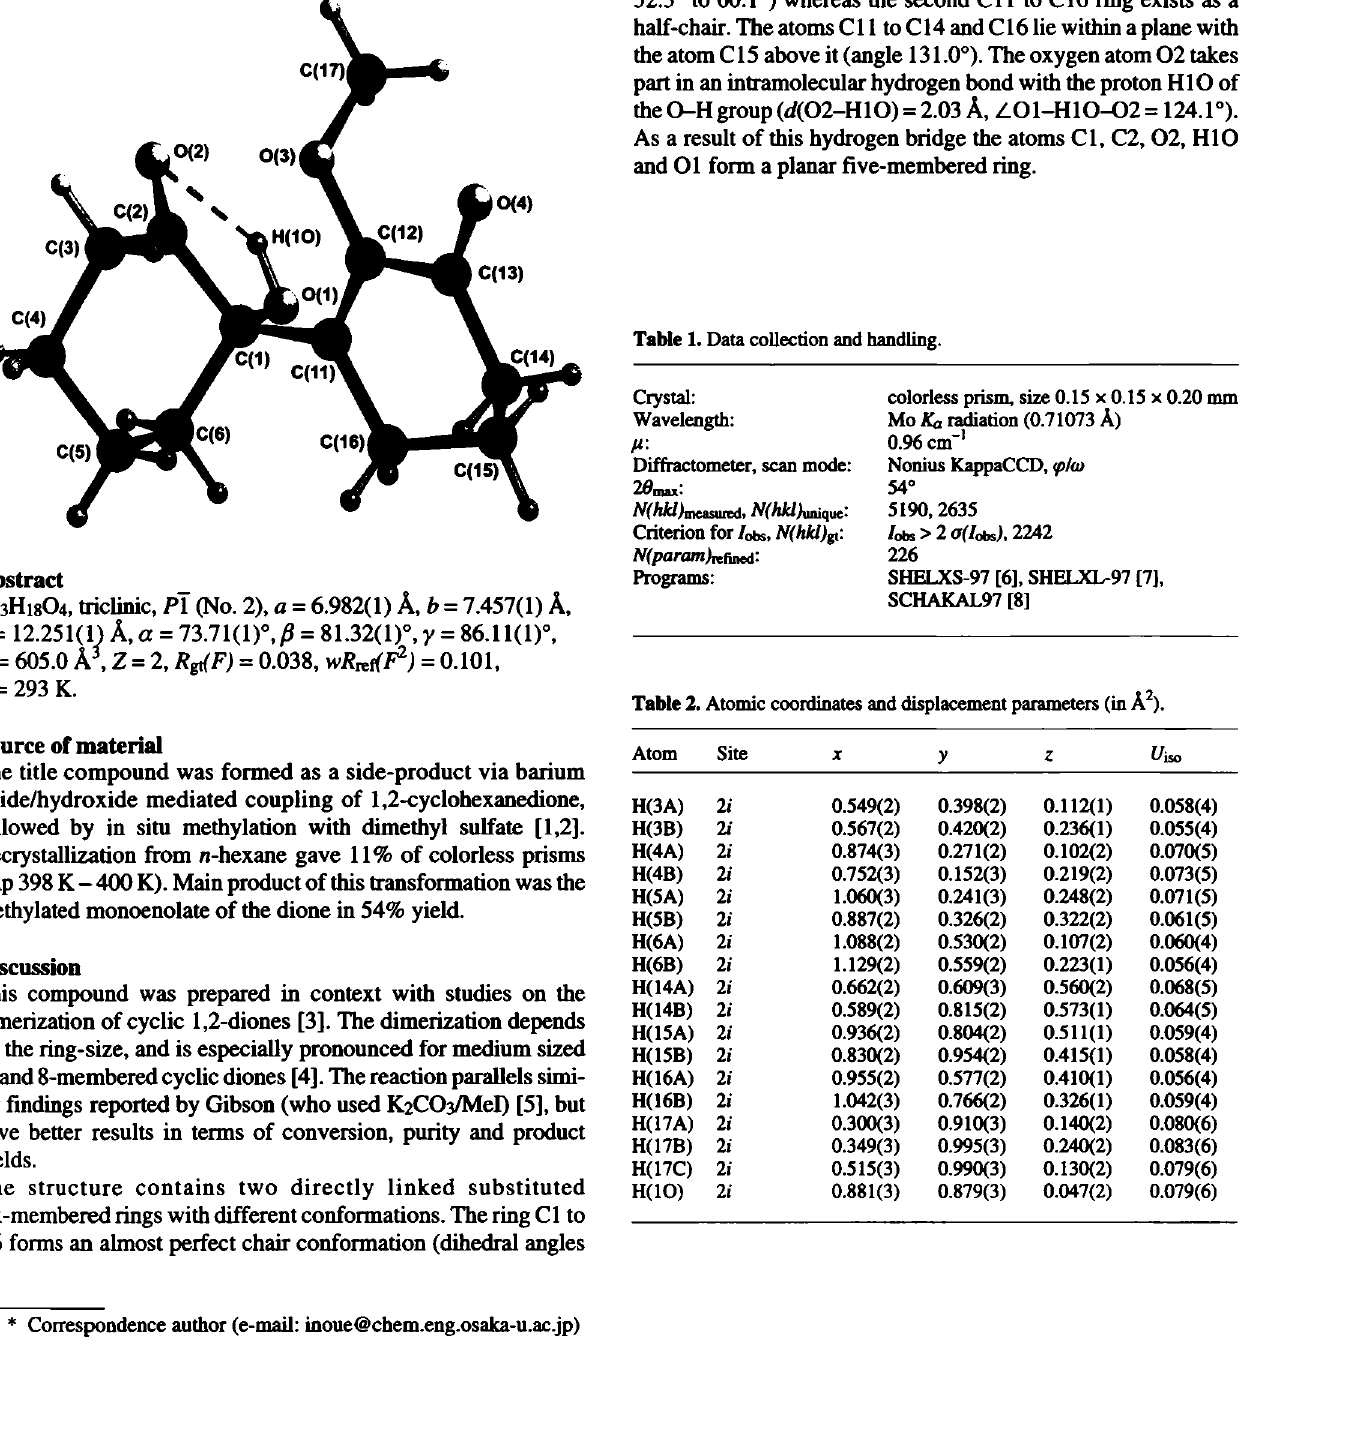
Table 1. Data collection and handling.